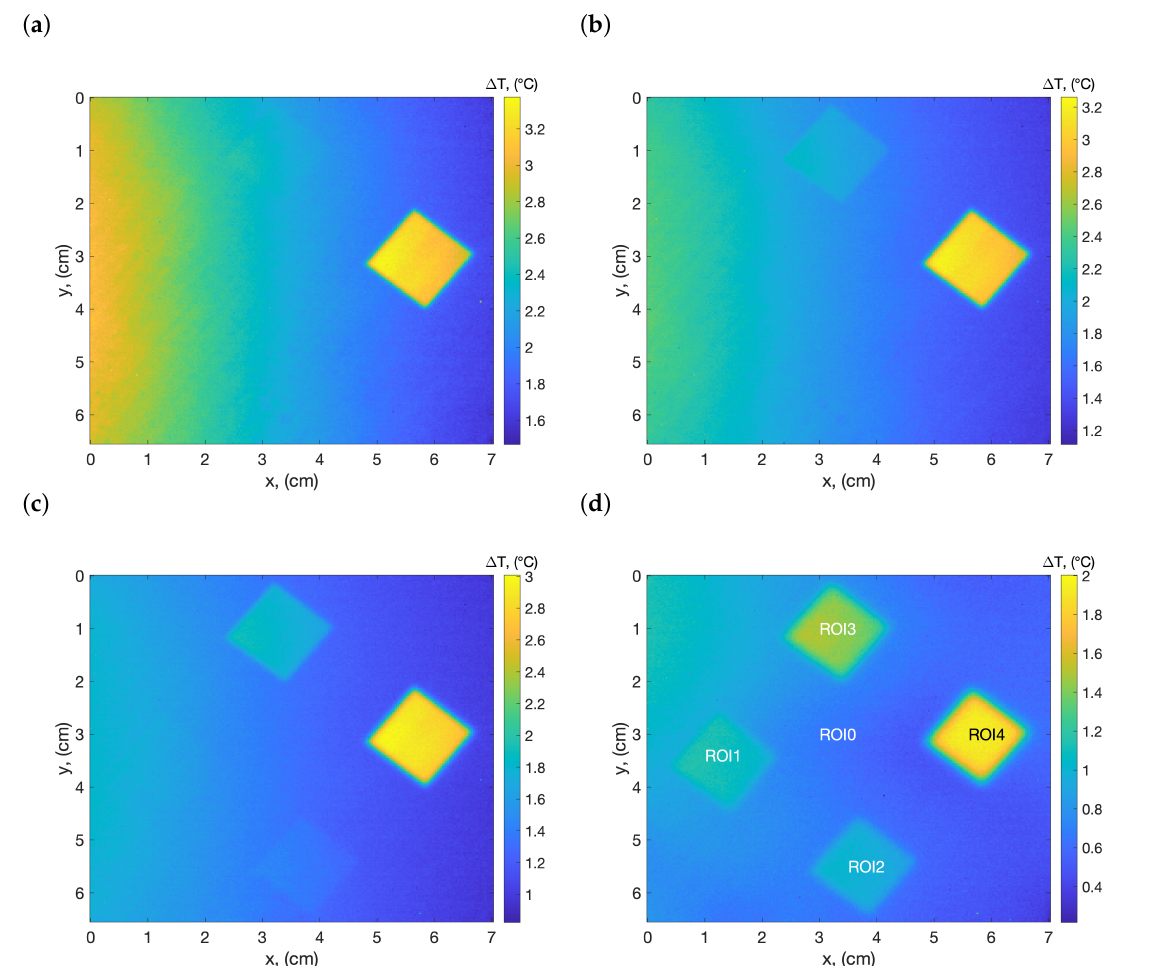
Figure 6. Temperature of the sample at ( a ) t = 0.87 s, ( b ) t = 1.12 s, ( c ) t = 1.67 s and ( d ) t = 5.12